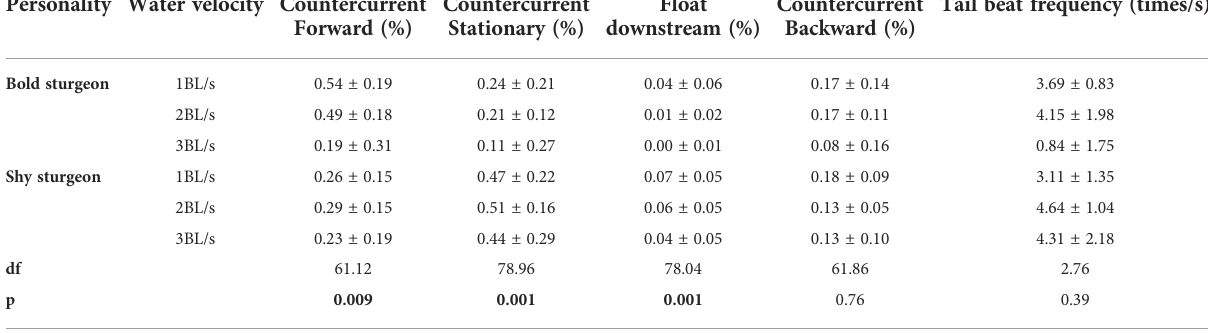
TABLE 2 Changes in the proportion of time spent in swimming state with individual differences and the tail beat frequency. Personality Water velocity Countercurrent Forward